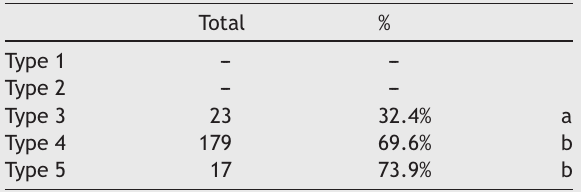
Sphenoid septation in the internal carotid artery protuberance by sinus